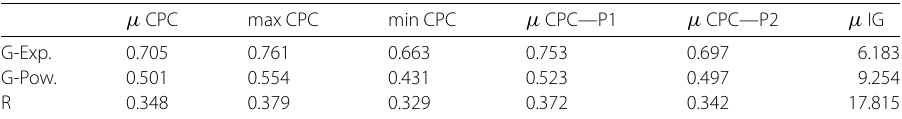
Table 2 The results in terms of CPC of the gravity model with exponential decay (G-Exp.), the gravity model with power law decay (G-Pow.), and the radiation model (R). We report the average CPC over the entire period under analysis ( μ ), the maximum and minimum CPC reached, and the average CPC of the first period (i.e., before the introduction of non-pharmaceutical interventions due to COVID-19 pandemic) and the second period (i.e., during the introduction of non-pharmaceutical interventions due to COVID-19 pandemic). The model that better captures incoming international mobility is G-Exp (0.685) followed by G-Pow (0.448) and R (0.348). We also report the average IG for each model ( μ IG). Number closer to 0 indicate better performances. Thus, the best performances are achieved by G-Exp. (6.183), followed by G-Pow (9.254) and, finally, the worst performances are reached by R (17.815) μ CPC max CPC min CPC μ CPC—P1 μ CPC—P2 μ IG